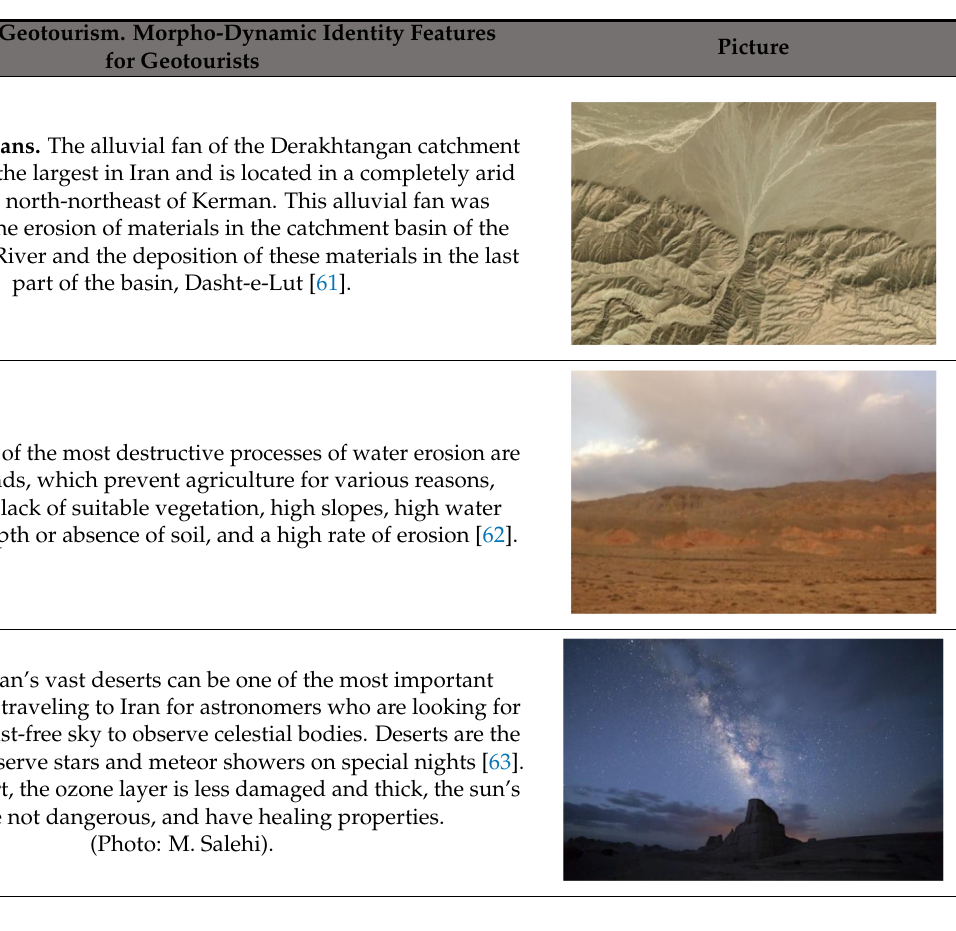
Geosites for Geotourism. Morpho-Dynamic Identity Features Figure